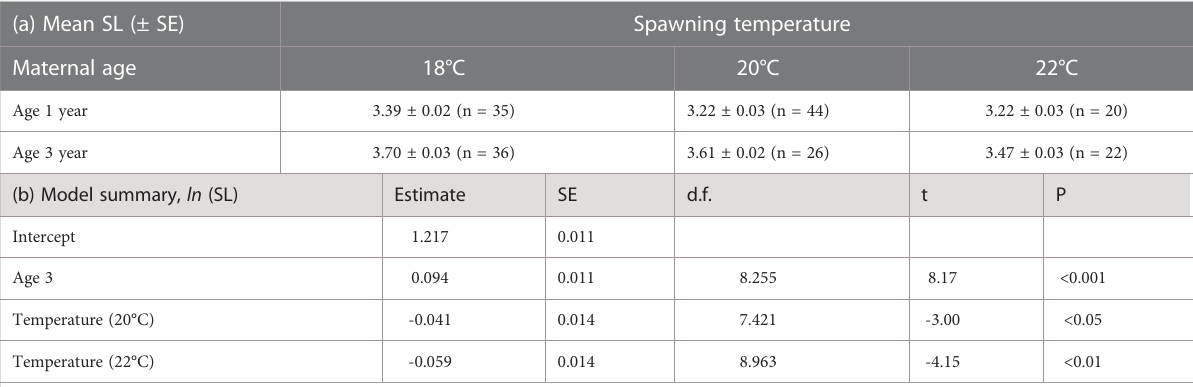
TABLE 3 Mean standard length (± SE) of fi rst-feeding larvae spawned by 1-year-old and 3-year-old females at different temperatures and summary table for linear mixed effects model fi tted using restricted maximum likelihood for the effect of maternal age on SL of fi rst-feeding larvae of chub mackerel.